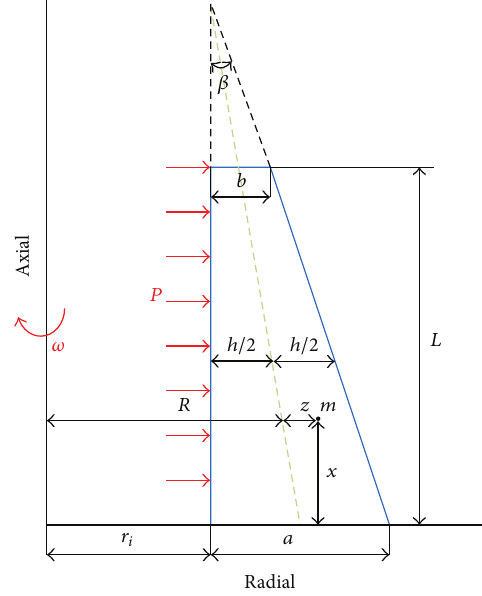
Figure 1: Thick cylindrical shell with variable